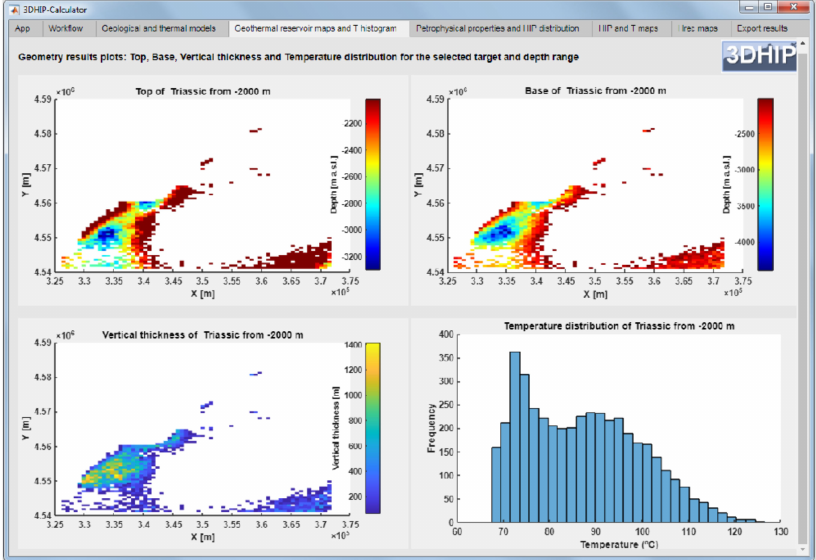
Figure 9. 2D distribution map of the top, base, and vertical thickness of the Triassic unit. Maximum depth and thickness are observed SW of the basin. The temperature distribution for the Triassic unit is shown in the bottom right